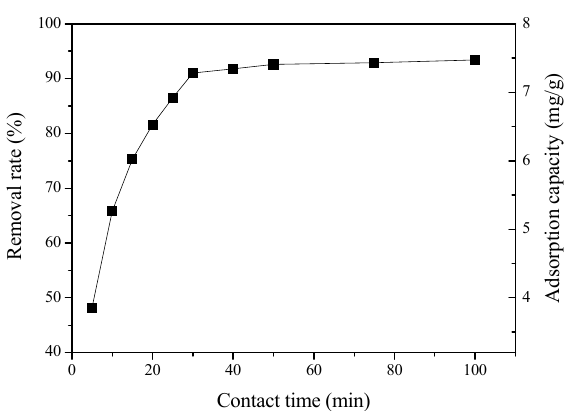
Figure 7. Effect of contact time on the adsorption of Ni 2+ by synthesized zeolite (pH 5, adsorbent dose 2.5 g/L, initial Ni 2+ concentration 20 mg/L).